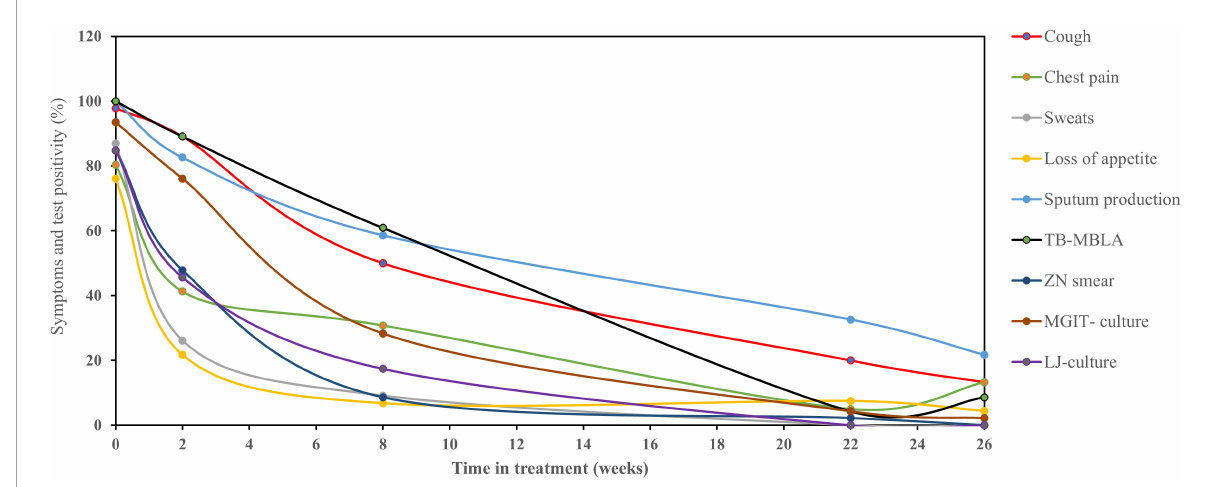
FIGURE2 Relationship of TB clinical symptoms clearance with bacteriological tests. Clinical symptoms resolved rapidly during TB therapy with the exception of cough and sputum production which resolved slowly than culture, microscopy, and TB-MBLA. Data are presented as the percentage (%) of patients with clinical symptoms and bacteriological positivity over the time in treatments (weeks).